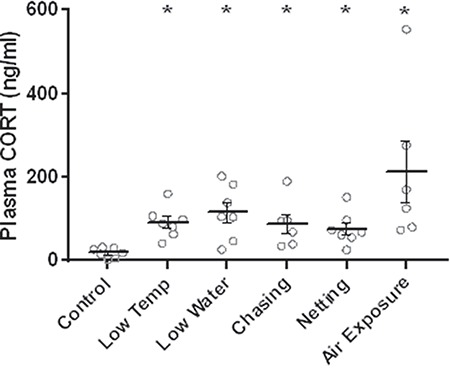
Validation of the five stressors used in the unpredictable chronic stress experiment. Significantly increased cortisol (CORT) levels compared to an unstressed control group are indicated by asterisks. Sample size is 7 per group, except for groups Chasing and Air Exposure (n = 6). Data are mean ± SEM